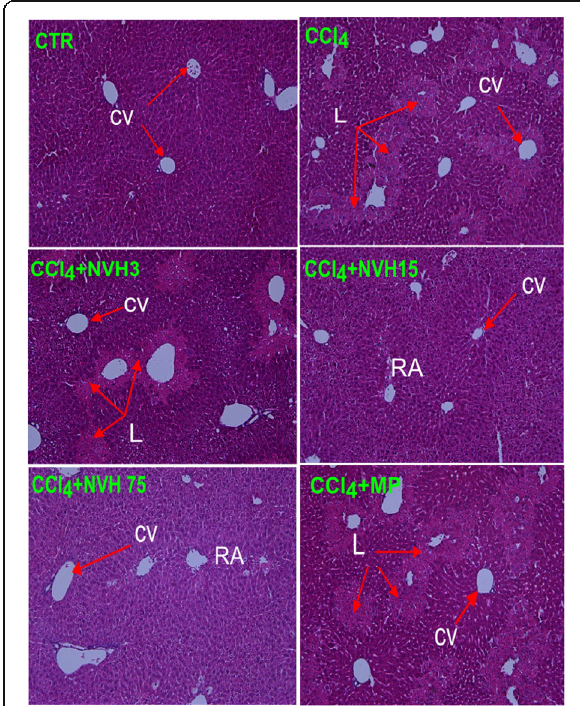
Fig. 7 Histological changes in CCl 4 -intoxicated mice. Animals were pretreated with NVH extract or methylprednisolone during 3 consecutive days. On the third day, acute liver injury was induced with CCl 4 . Mice were sacrificed 24 h after CCl 4 injection. Liver sections were fixed and paraffin-embedded before haematoxylin- eosin staining. CTR: Control mice with a normal liver structure; CCl 4 : carbon tetrachloride-treated mice with a damaged liver; CCl 4 + NVH (3, 15 and 75): carbon tetrachloride and extract-treated mice with regenerating areas at highest doses; CCl 4 + MP: carbon tetrachloride and methylprednisolone treated mice with persistent lesions. NVH: Neoboutonia velutina aqueous extract; MP: Methylprednisolone; CCl Carbon tetrachloride; CV: Centrilobular vein; L: Necrotic area; RA: Regenerating area. HEx100